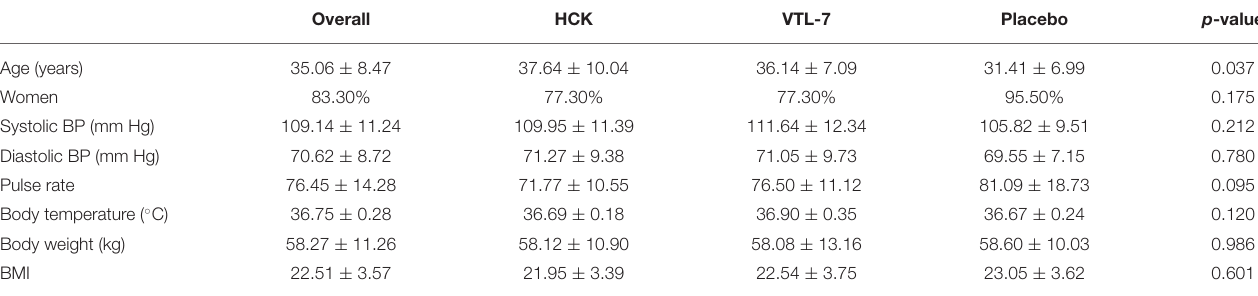
TABLE 1 | Characteristics of the participants.